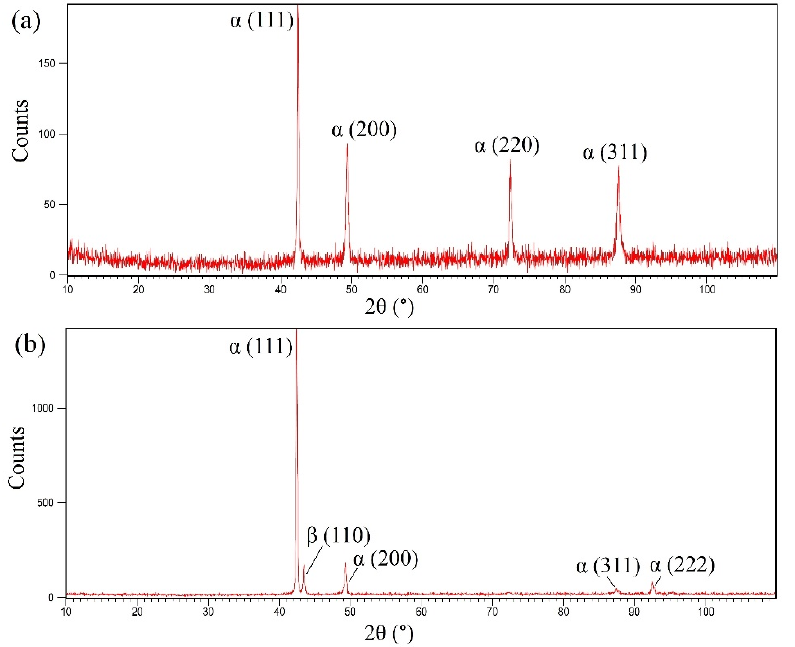
Figure 3. XRD results of the single-phase ( a ) and double-phase ( b ) brasses showing the β (110) peak after heat treatment in double-phase sample.